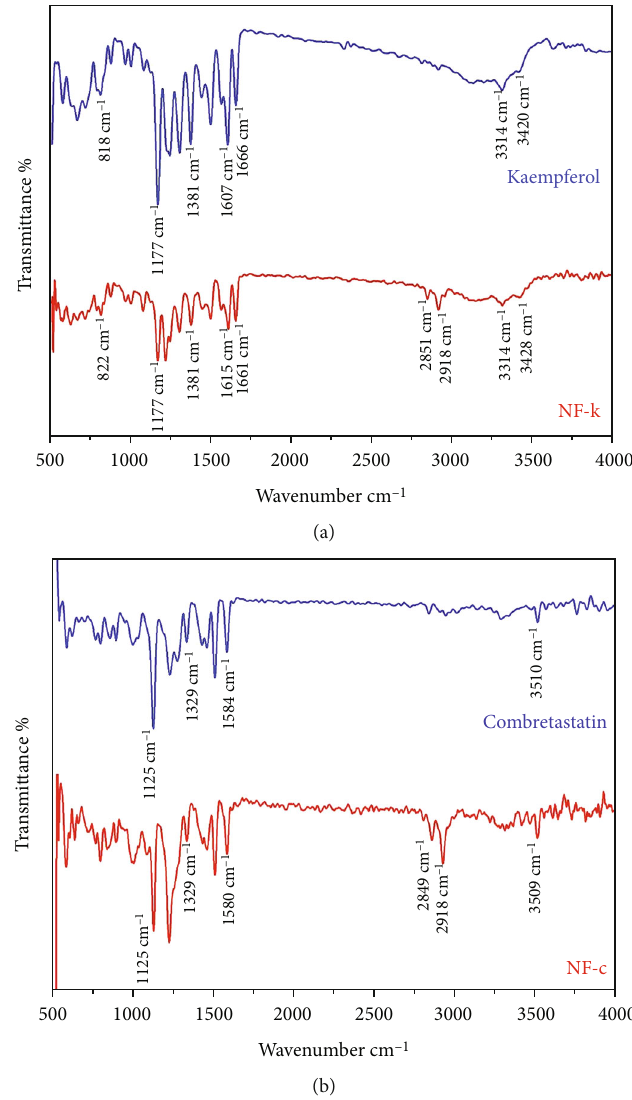
Figure 5: FTIR spectra of (a) kaempferol and NF-k and (b) combretastatin and